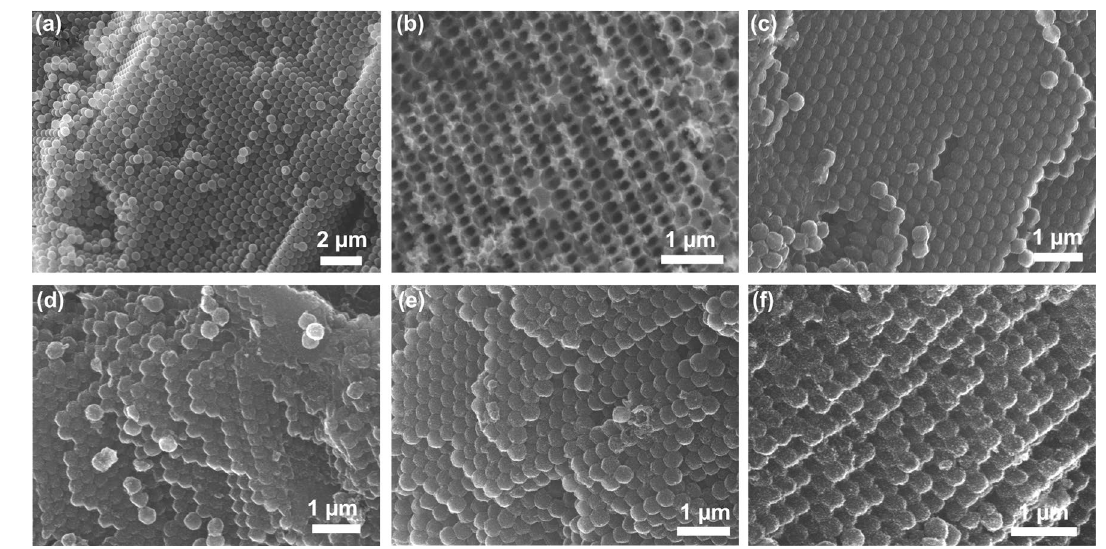
Fig. 1 SEM images of a PMMA opal, b silica inverse opal, c OMCS, d ZnO/OMCS-20, e ZnO/OMCS-30 and f ZnO/OMCS-40